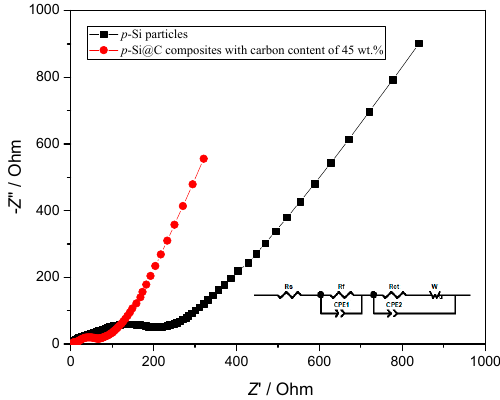
Figure 7. Nyquist plots for p -Si particles and p -Si@C composites.